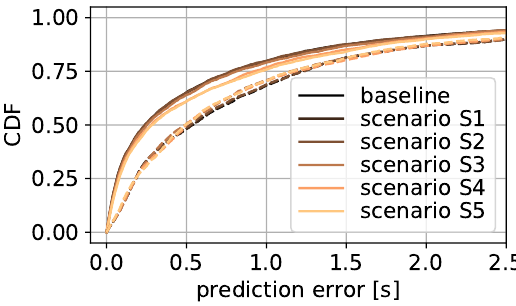
Figure A7. Feature set